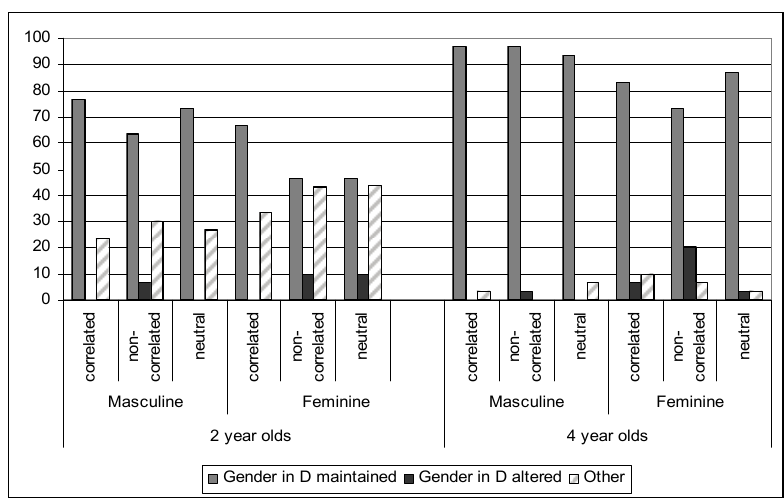
Figure 4. Distribution (%) of responses per condition in the EP group